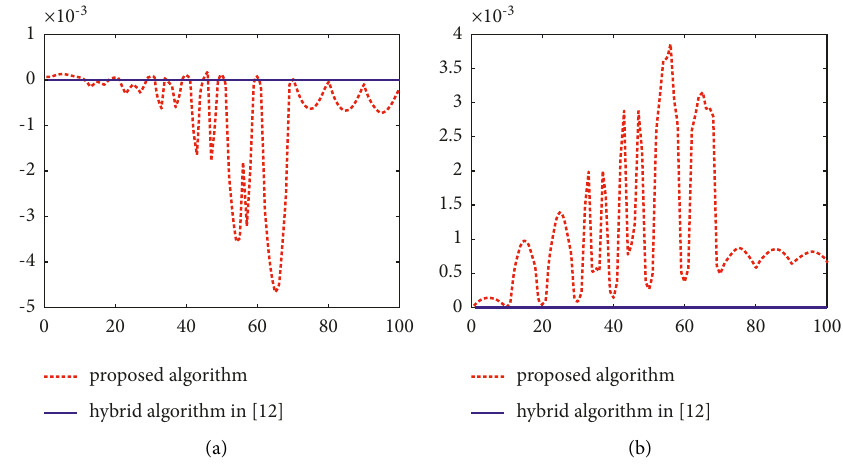
Figure 20: The error curves of relative permittivity obtained by the two algorithms. (a) Real part. (b) Imaginary